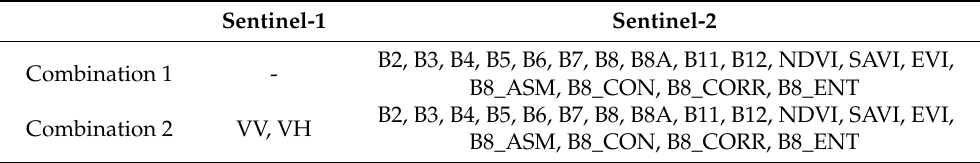
Figure 12. Timing-series features of VV. Table 5. Band combinations in this study.